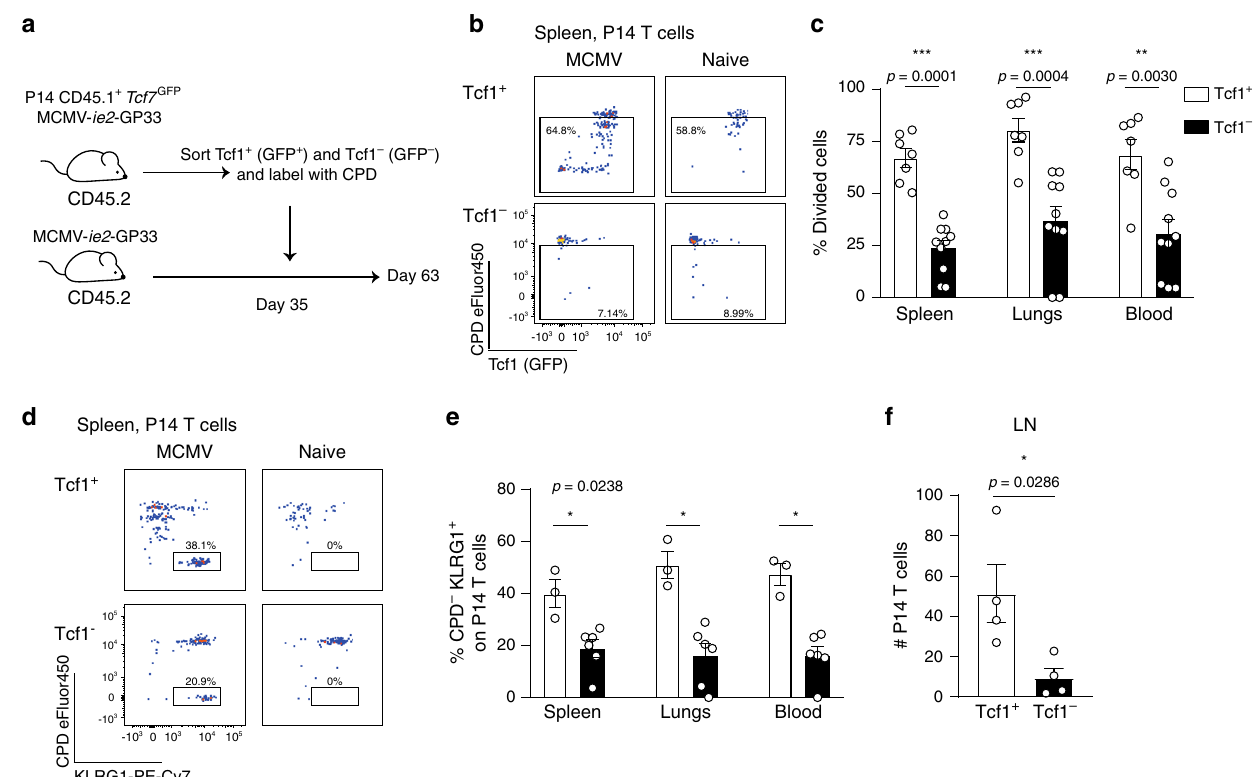
Fig. 4 Tcf1 + cells have proliferative capacity and give rise to Tcf1 − KLRG1 + cells. a Experimental setup: Tcf7 GFP P14 T cells were adoptively transferred into CD45.2 + mice that were subsequently i.v. infected with 2 × 10 5 PFU MCMV- ie2 -GP33. After 5 weeks, Tcf1 + and Tcf1 − P14 cells were sorted based on GFP, subsequently labelled with a cell proliferation dye and 5 × 10 4 P14 T cells were adoptively transferred into infection-matched recipients. Naïve hosts received 1 × 10 5 P14 T cells. Four weeks post adoptive transfer, the proliferation pro fi le of the P14 T cells was determined. b Representative fl ow cytometry plot shows the proliferation history based on CPD dilution versus Tcf1 expression indicated by GFP on P14 T cells in the spleen. c The percentage of P14 cells in the spleen, blood and lungs that have proliferated at least once based on their CPD dilution, 28 days after adoptive transfer, is shown. Pooled data from two experiments are shown ( n = 7 – 10). d Representative fl ow cytometry plot shows the proliferation history based on CPD dilution versus KLRG1 expression on P14 T cells in the spleen ( n = 3 – 6). e The percentage of P14 cells that has out-diluted the CPD and expresses KLRG1 is shown. f The total number of P14 T cells in the LN is shown ( n = 4). All bar graphs represent mean ± SEM, each dot represents an individual mouse. Data are representative from three independent experiments ( n = 3 – 6 mice). * p < 0.05, ** p < 0.01, *** p < 0.001; statistical signi fi cance was determined using the two-sided non- parametric Mann – Whitney test. Source data are provided as a Source Data File.